Question: What direction does the quantity move in — increasing or decreasing?
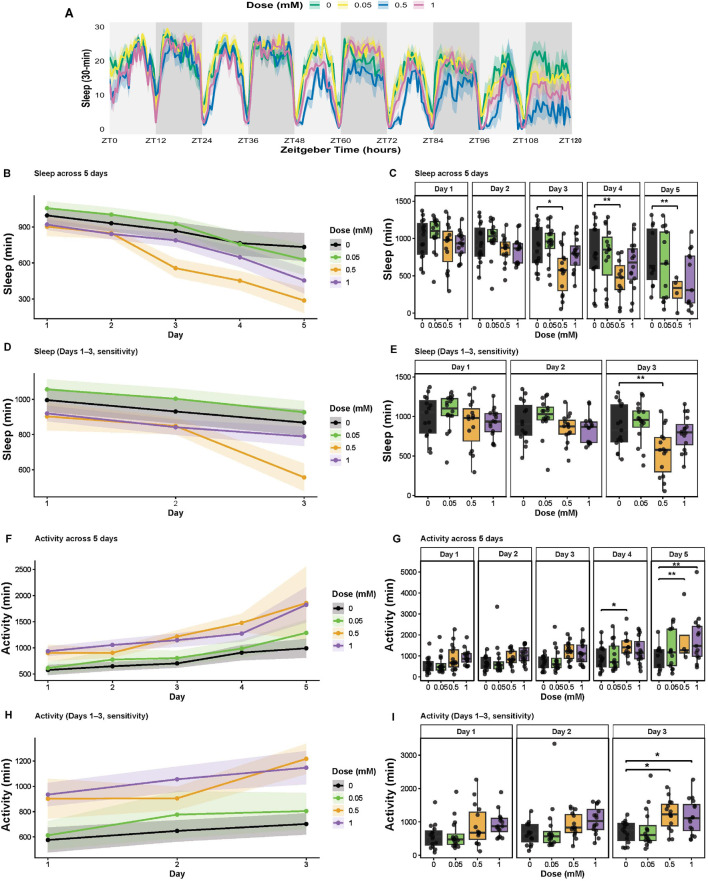
Answer: increasing